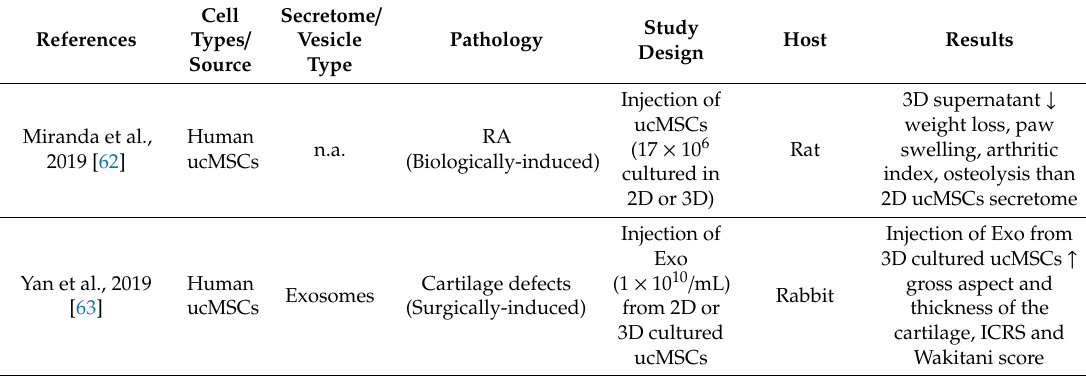
Table 3. Details of the papers describing clinical trials with MSCs from the umbilical cord for the treatment of joint diseases. Abbreviations: cbMSCs: cord blood mesenchymal stem cells, HA: